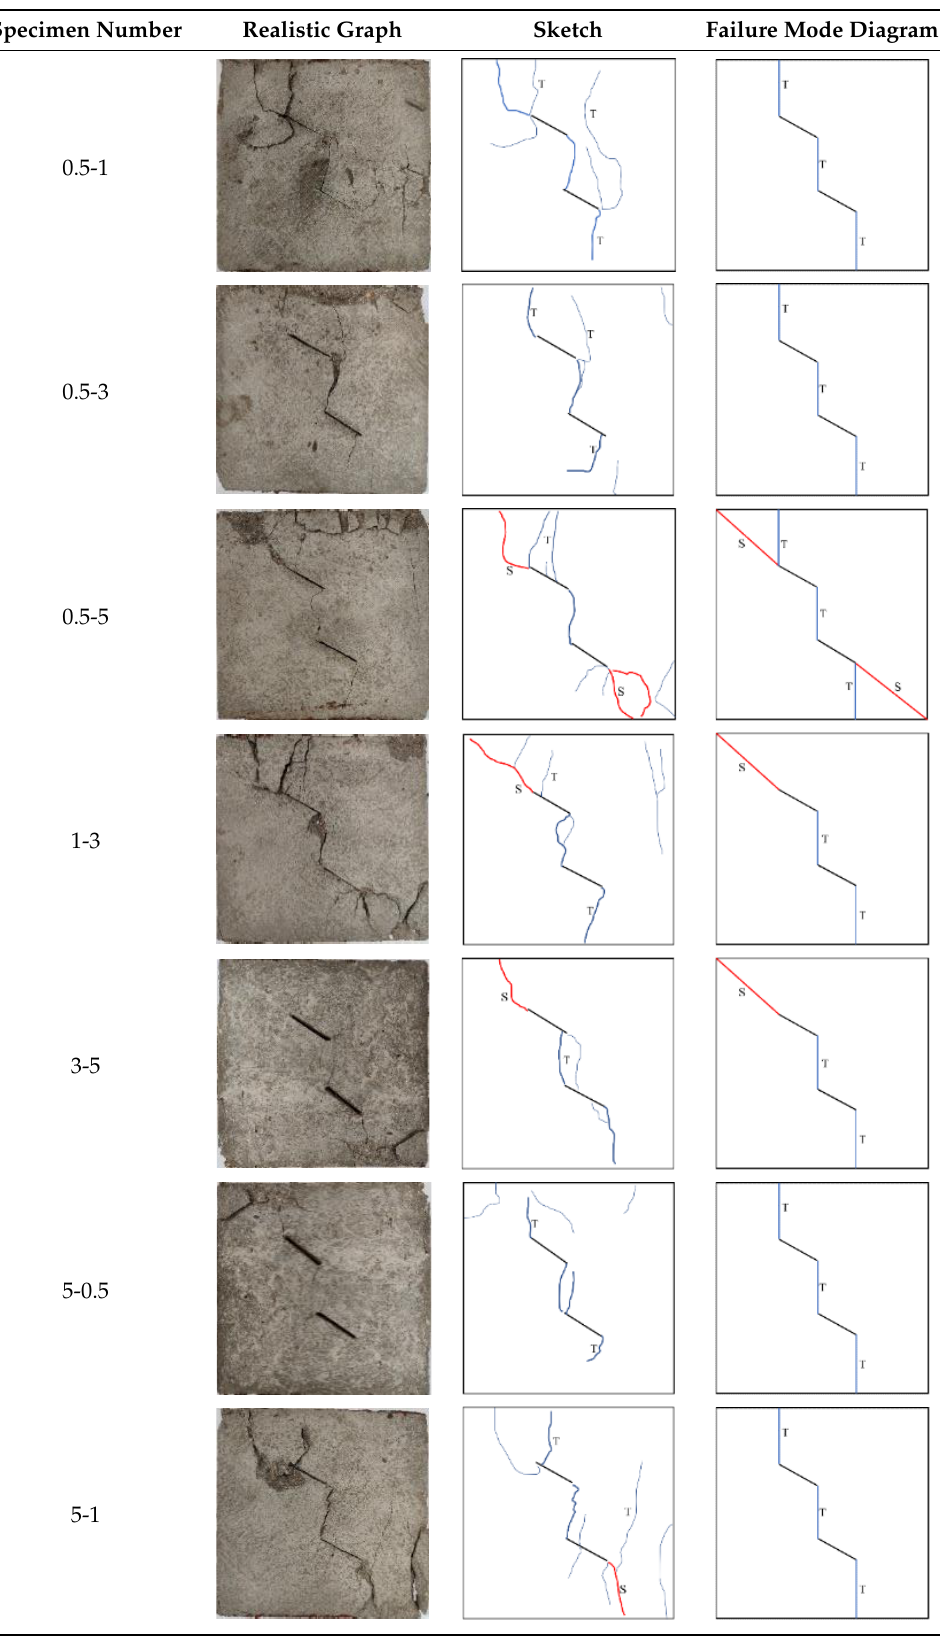
Table 3. Specimens #2 of different sudden change rate crack propagation diagram.